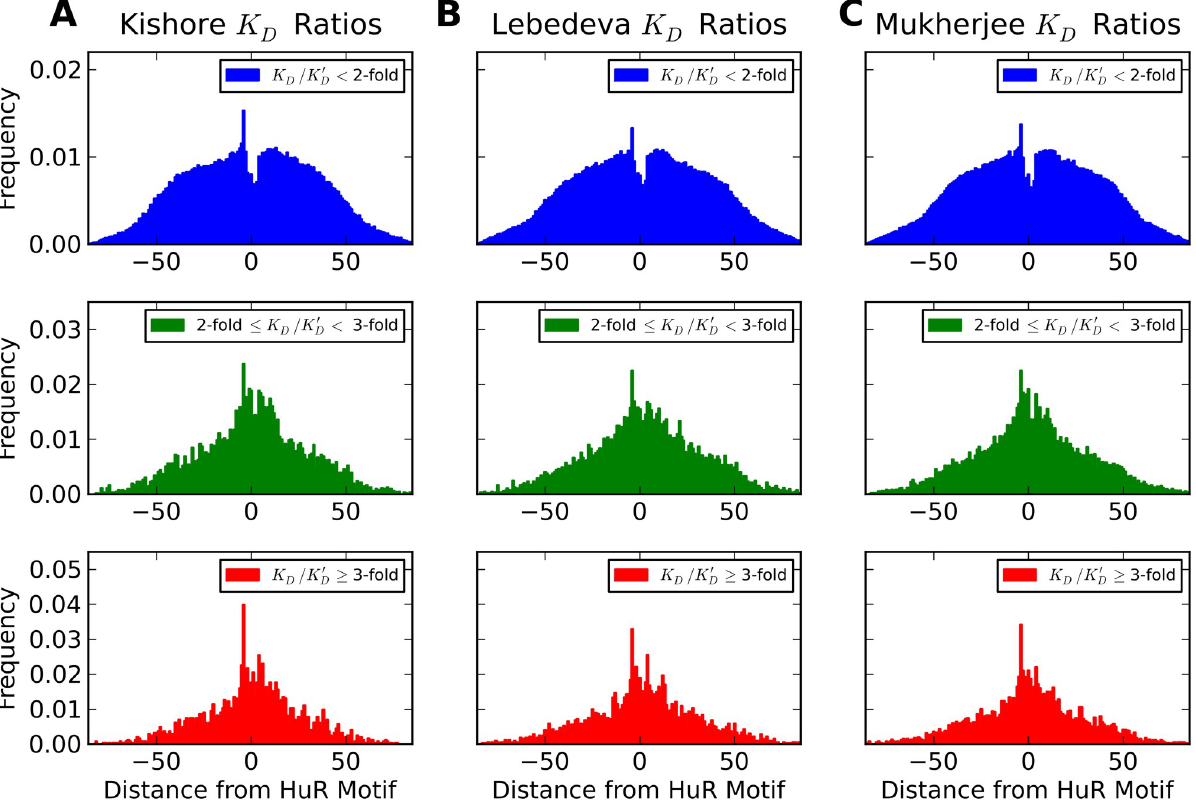
Fig 4. Effect of distance from motif on change of binding affinity due to SNPs in 201 nucleotide sequences. Histograms of distances of SNP locations from the center of the nearest HuR binding motif for (A) the Kishore data set, (B) the Lebedeva data set, and (C) Mukherjee data set for different strengths of their effects on HuR binding. Distances where the SNP is upstream of the motif are negative. The top (blue) histograms are of SNPs with an absolute fold change (positive or negative) in binding affinity less than 2, the middle (green) histograms are of SNPs with a fold change between 2 and 3, and the bottom (red) histograms are of SNPs with a fold change of 3 or